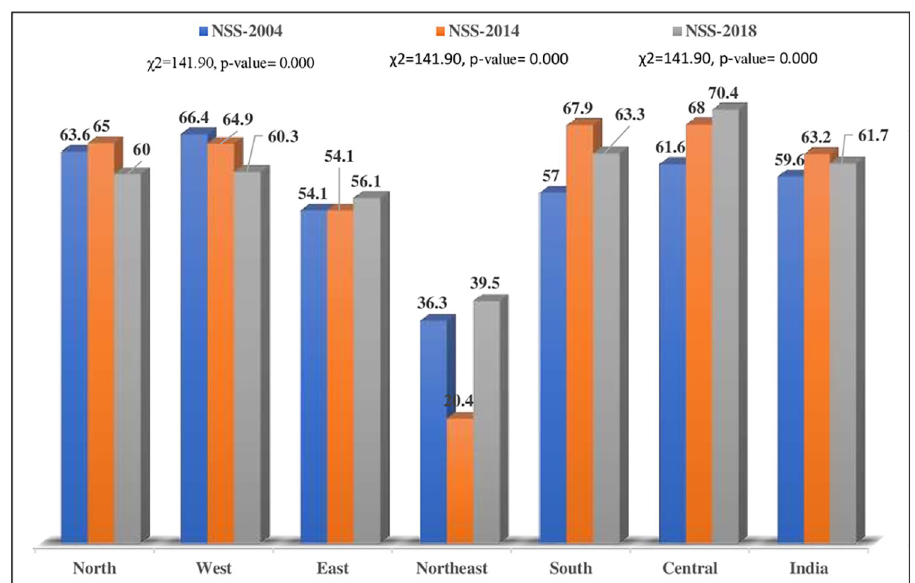
Fig 3. Unmet need for treatment-seeking from public health facilities among those who suffered/are suffering from any disease by region of residence in India, NSS, 2004–2018.